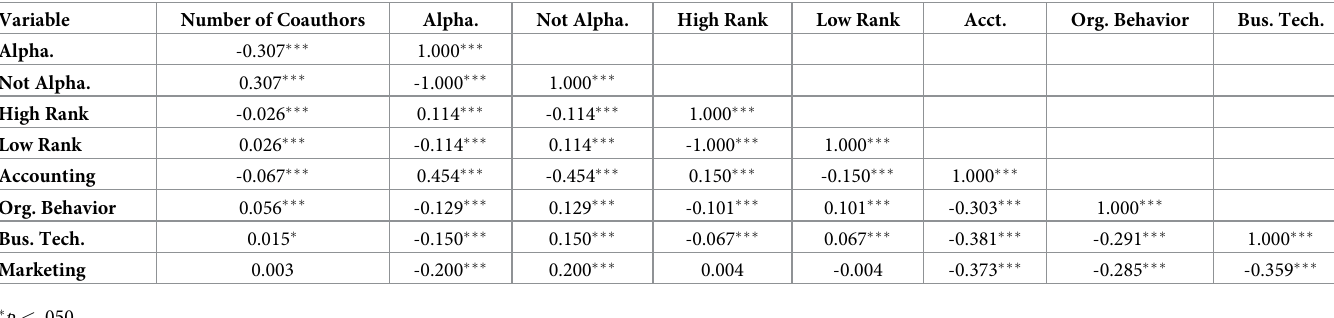
Table 2. Pearson correlation